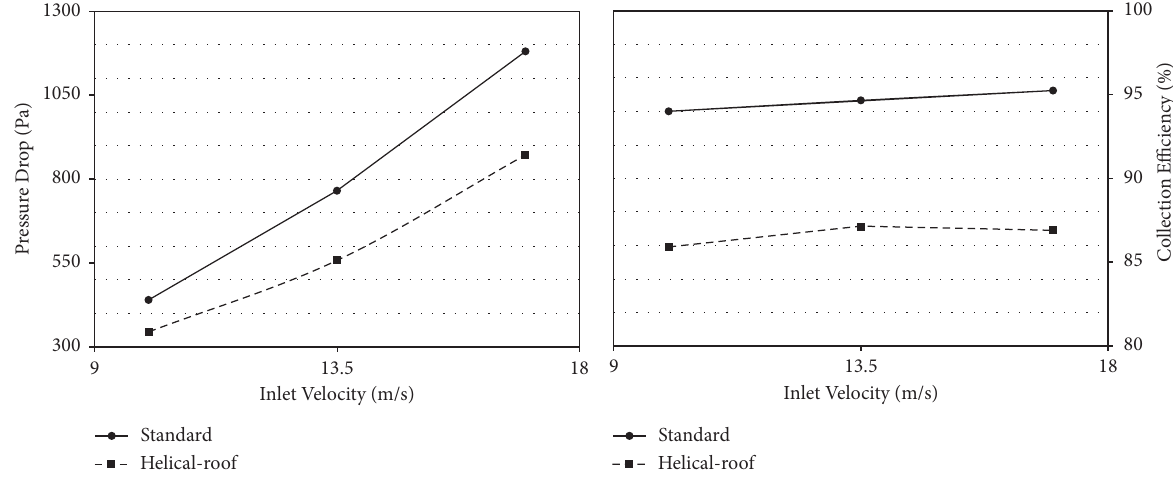
Figure 3: Pressure drops and collection efficiencies for inlet velocities of 10m s − 1 , 13.5m s − 1 , and 17m s − 1 . Table 2: Cut diameters of cyclone